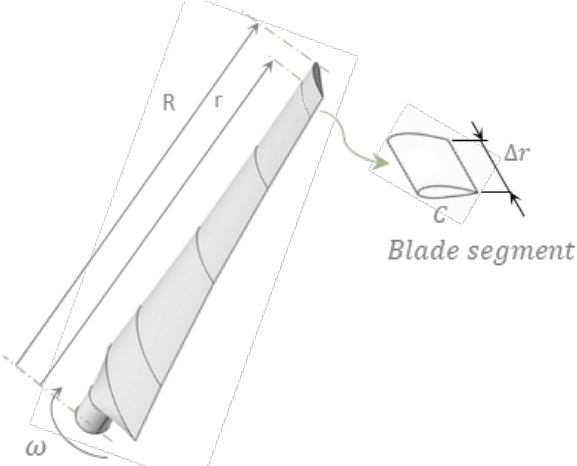
Figure 1. Schematic of blade elements; C , airfoil chord length; R , rotor radius; r , the element’s radius; dr , the radial length of the element; ω , rotor angular velocity. @Fahed Martini. The thrust (normal force T N ) and torque (tangential force T Q ) acting on the annular section of the rotor are a function of the axial ( a ) and tangential ( a (cid:48) ) induction factors can be described by equations from the MT